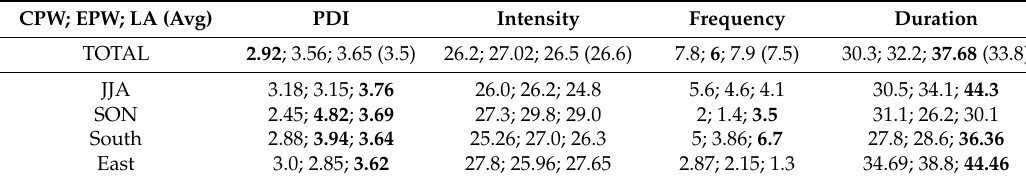
Table 2. The average PDI, intensity, frequency and duration of TCs making landfall in CPW, EPW, and LA years during different seasons (JJA and SON) and over different landing locations (south and east). “Avg” in brackets indicates the total average during period of 1960–2016. The results compared with each other in three ENSO states that are statistically significant at 85% confidence level are in